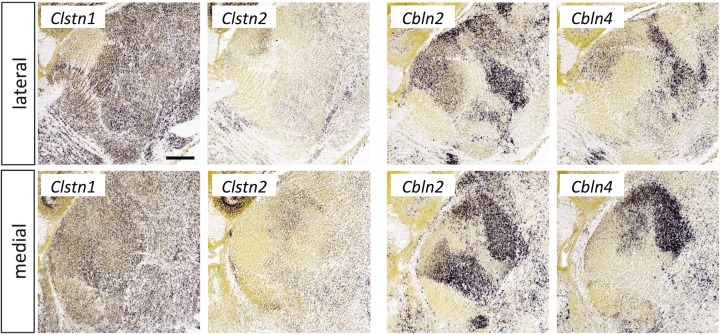
Calsyntenin and cerebellin expression in the thalamus at E18.5.In situ hybridization data from sagittal sections of the thalamus at E18.5 obtained from the devABA revealed differential patterns of expression of Calsyntenin (Clstn) 1 and 2, and Cerebellin (Cbln) 2 and 4. See text for details. Two representative and equivalent sections are shown for each gene, one lateral and the other medial (see S8 Fig for details on how the sections were selected). Scale bar in Clstn1: 332 μm.